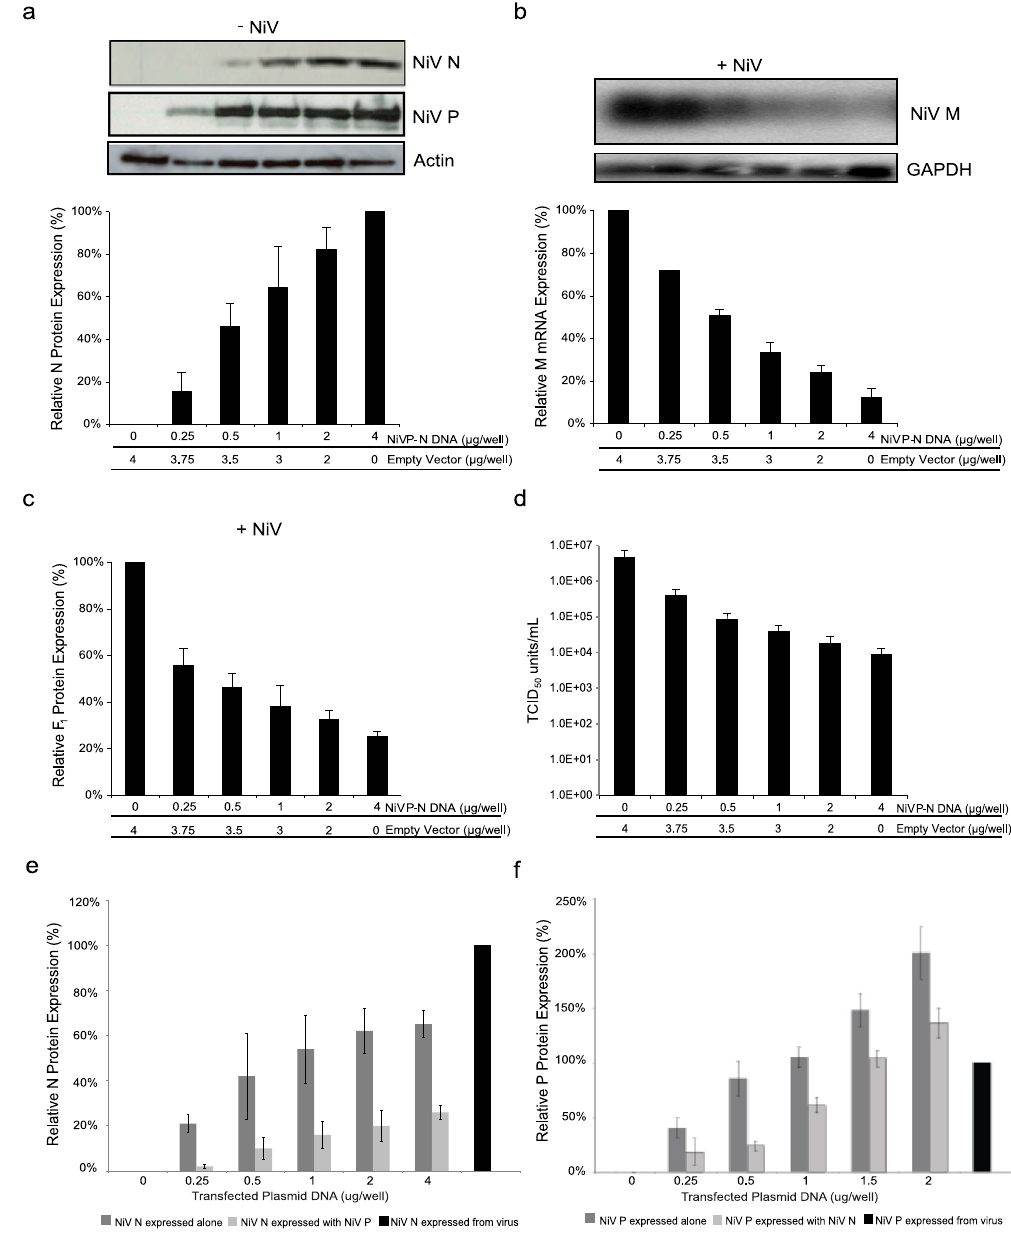
Figure 5. Effects of increasing recombinant NiV N proteins co-expressed with NiV P proteins on NiV replication. Cells were transfected with increasing amounts of plasmid DNA, containing both the NiV N gene and NiV P gene, which are driven by individual promoters encoded on one construct for 48 hours. ( a ) Cells were harvested and analyzed by western blot using a monoclonal antibody against NiV N. Following transfection, a parallel set of cells were infected with NiV at an MOI of 1 for 24 hours. ( b ) RNA was extracted from NiV infected cells and analyzed by northern blot using a probe designed against the M gene. Northern blots were quantified by densitometry and normalized to GAPDH. ( c ) Total protein was harvested from NiV infected cells and analyzed by western blot for the expression of NiV F 0 proteins. ( d ) Supernatants were harvested, viral loads were determined by endpoint titration, and TCID 50 /ml was calculated. ( e ) Cells were transfected with increasing amounts of plasmid DNA expressing NiV N and/or NiV P protein for 48 hours or infected with NiV at an MOI of 1 for 24 hours. Total protein was harvested and a western blot was performed to visualize the presence of NiV N proteins or ( f ) NiV P proteins. All western blots were quantified by densitometry and normalized to actin. All experiments were carried out in triplicate and standard deviations of the mean were calculated. Blots have been cropped to ease